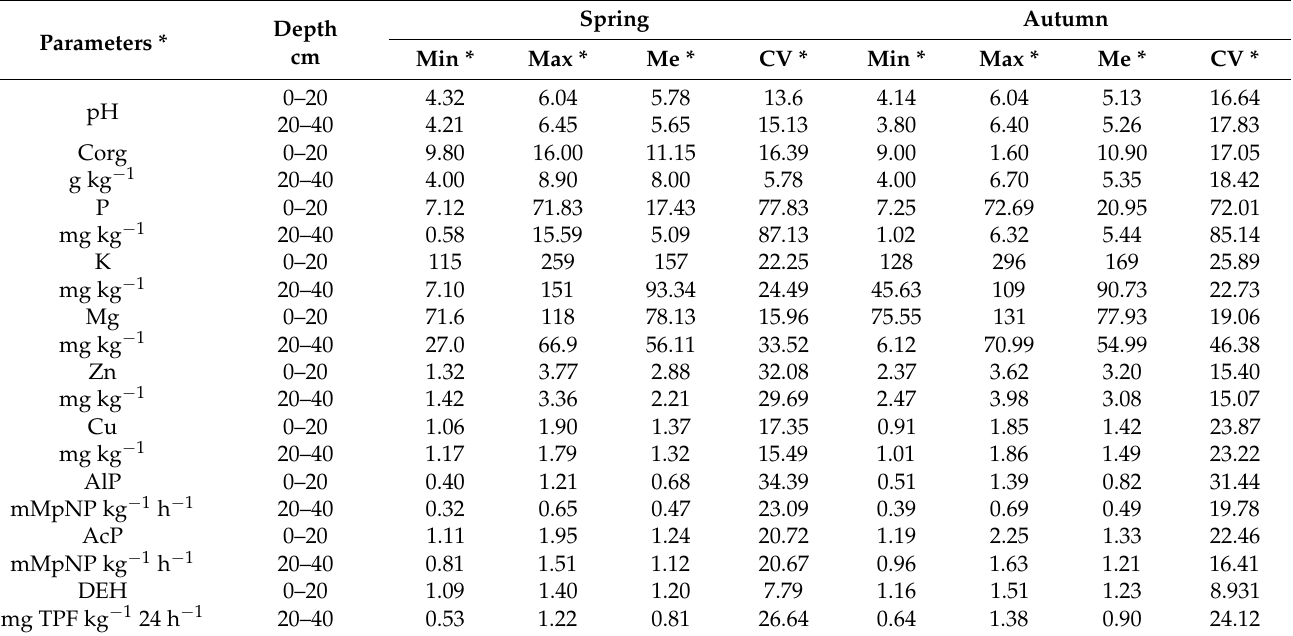
Table 4. Selected physicochemical and biochemical properties of the soil in the second year after the application of the stillage (2020).